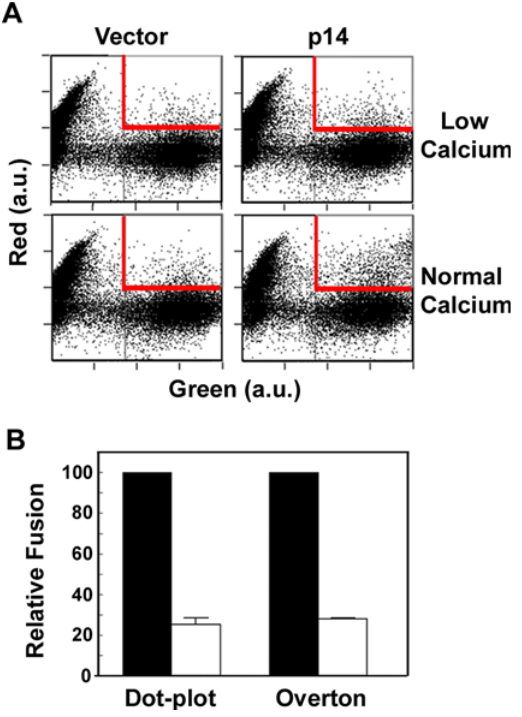
Figure 3. p14-induced cell–cell membrane fusion is calcium- dependent. (A) Two populations of QM5 cells, one labelled with calcein red orange AM (Red) and the other expressing EGFP (Green), were co-cultured, transfected with p14 or empty vector, then cultured under normal or low calcium conditions for 3 h to allow fusion to proceed. Trypsinized, single-cell suspensions were analyzed by flow cytometry, using the increase in cells positive for both green and red fluorophores (gated area shown in red) as an indicator of content mixing. Axes are in arbitrary units (a.u.) of fluorescence intensity. Data is representative of four experiments conducted in duplicate. (B) The gated populations of co-fluorescent p14-transfected cells shown in the dot plots in panel A were quantified, and results are presented as the relative fusion under low (white bars) versus normal (black bars) calcium conditions. Similar analysis was performed using Overton subtractions to quantify the extent of the increase in green fluorescence of the gated red cells.